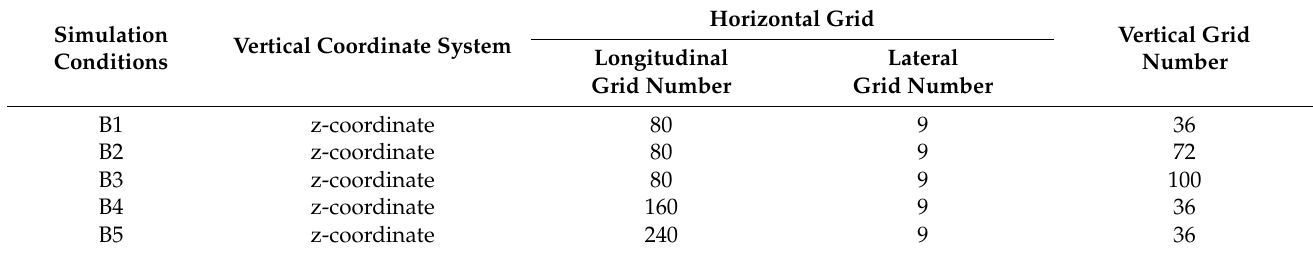
Table 3. Simulation conditions with different grid resolutions in the z-coordinate system model.